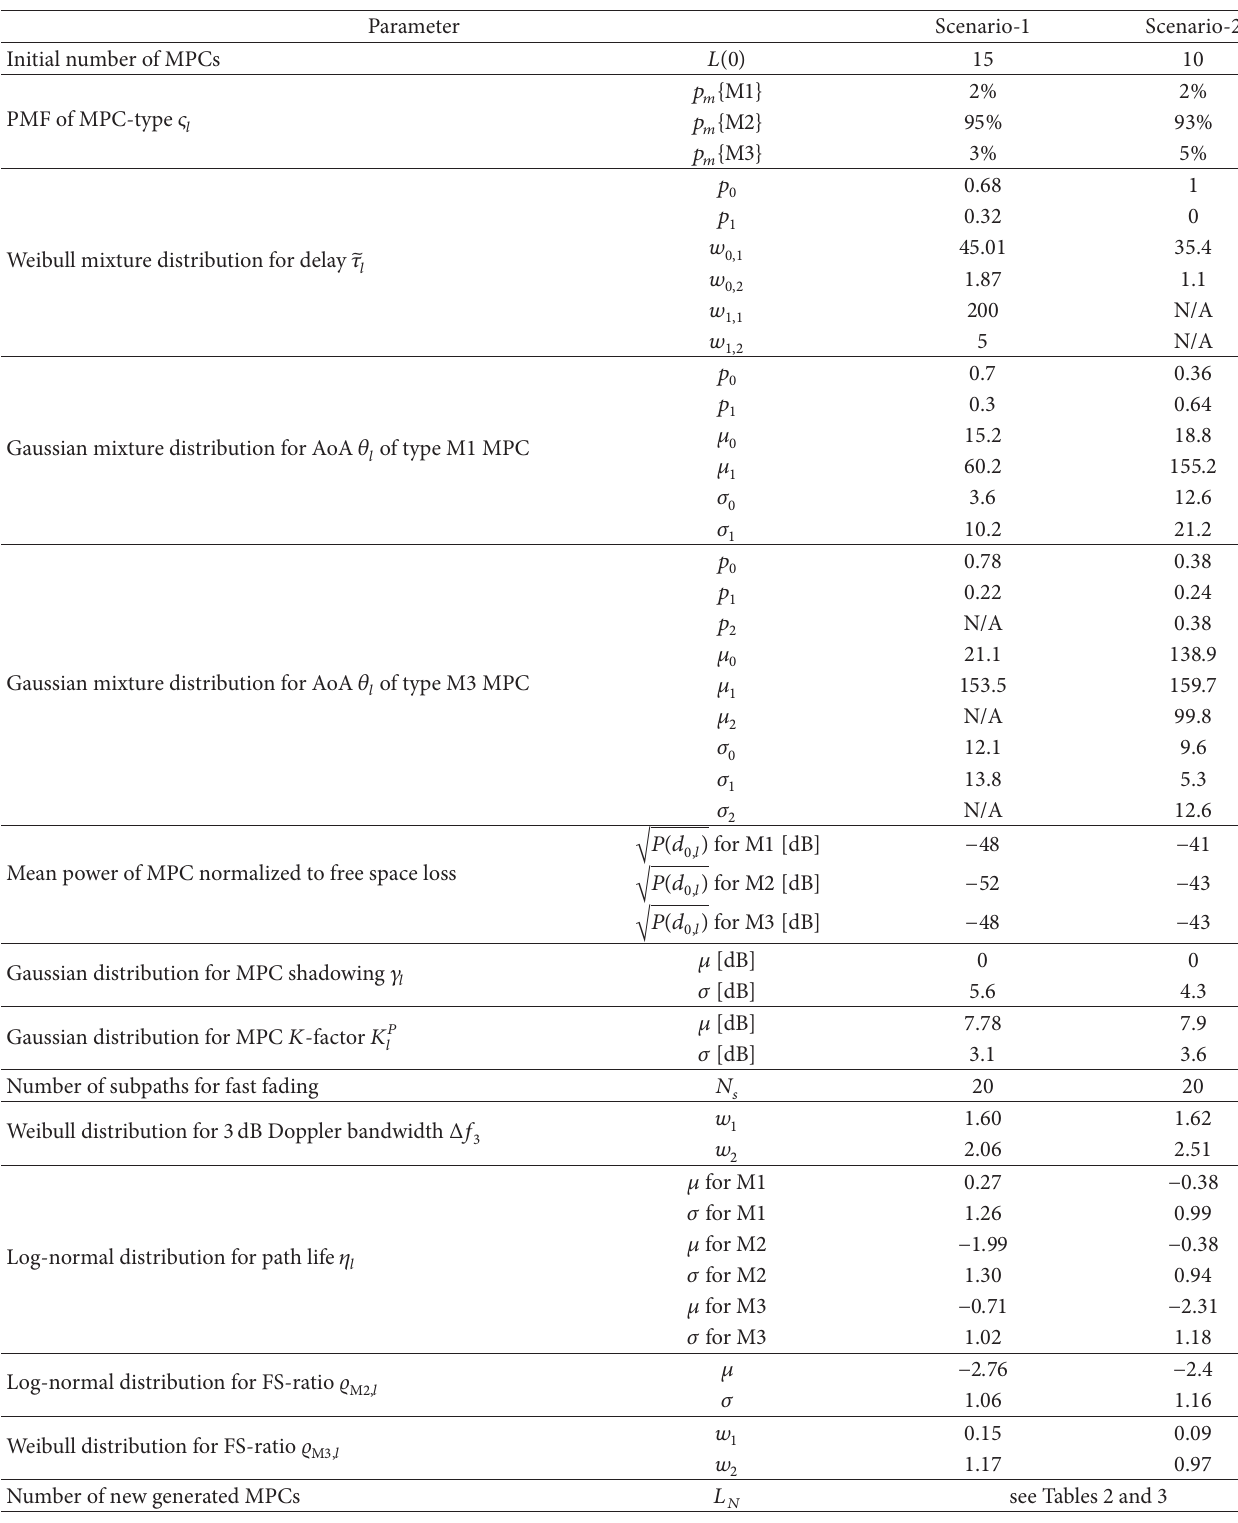
Table 1: Summary of the parameters used in the channel